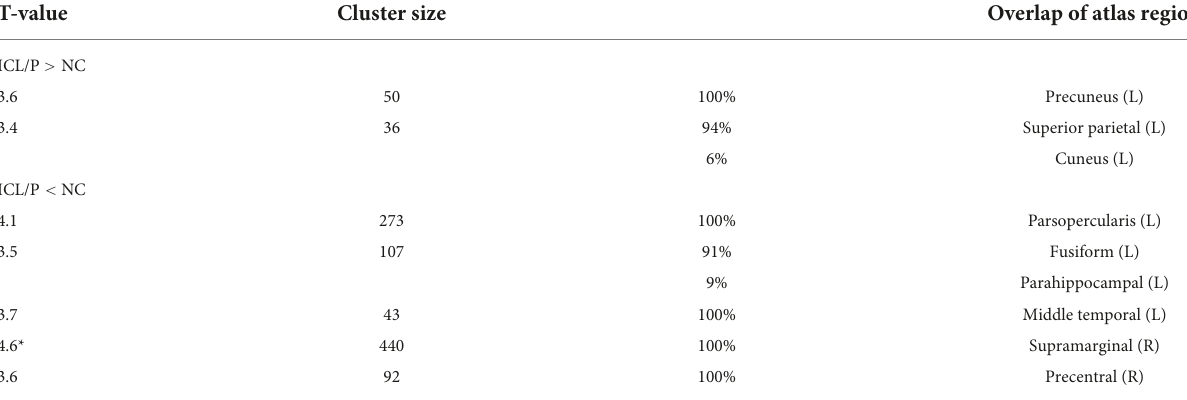
TABLE 2 Intergroup cortical thickness (CT) difference between the isolated clefts of the lip and/or palate (ICL/P) and normal controls (NC).